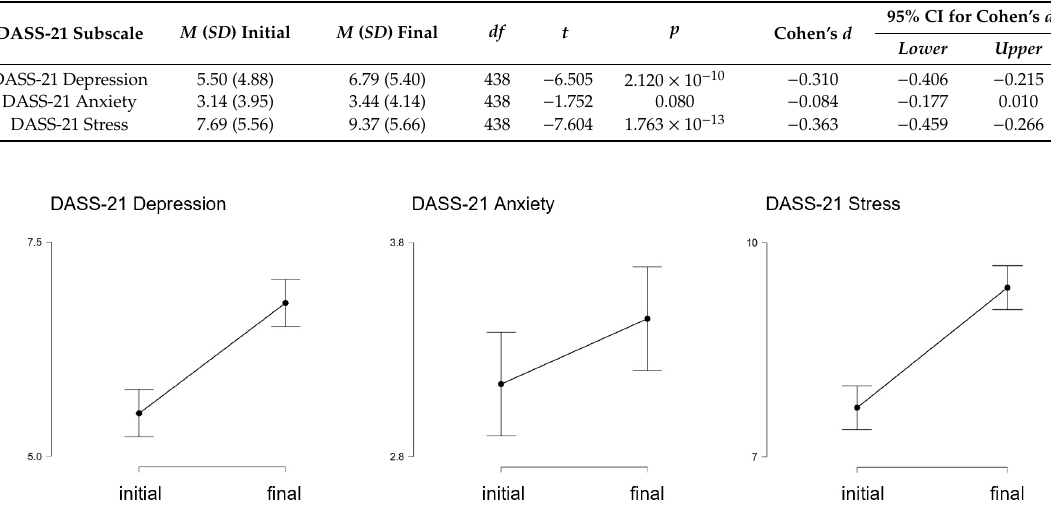
Table 2. Di ff erence Between the Initial and the Final Period of the Lockdown in Levels of Stress, Anxiety, and Depression, as Measured with the DASS-21.